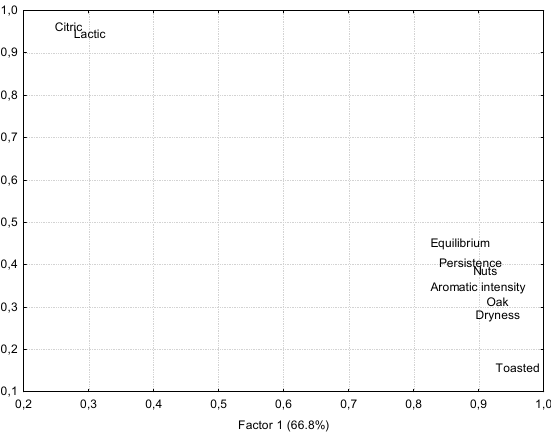
Figure 5. Weight of the sensory descriptors with respect to the first factors in the factorial space obtained.